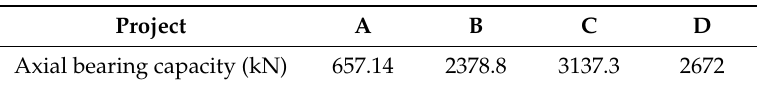
Figure 10. Axial bearing capacity-displacement curve. Table 4. Axial bearing